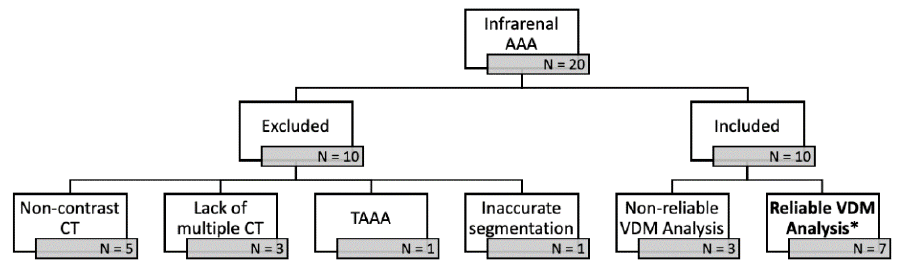
Figure 2. Twenty patients with previously diagnosed infrarenal abdominal aortic aneurysms (AAA) were identified through a review of electronic medical records. Of these patients 10 were excluded because of non-contrast imaging ( n = 5), lacking multiple CT scans ( n = 3), thoracoabdominal aneurysm (TAAA) ( n = 1), and/or adjacent soft tissue structures (i.e., bowel/inferior vena cava) preventing accurate segmentation of the aortic wall ( n = 1). Of the 10 patients that were included in the study, 7 had VDM analyses * that were deemed reliable after quality assessment steps.